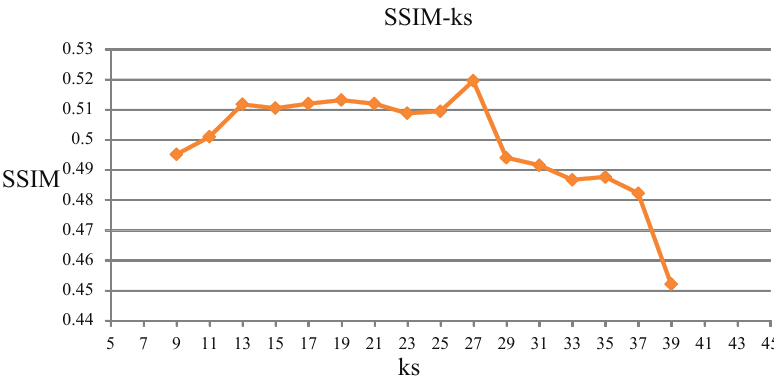
Figure 5. Evaluation of the parameters. SSIM values with different kernel size on the experiments.